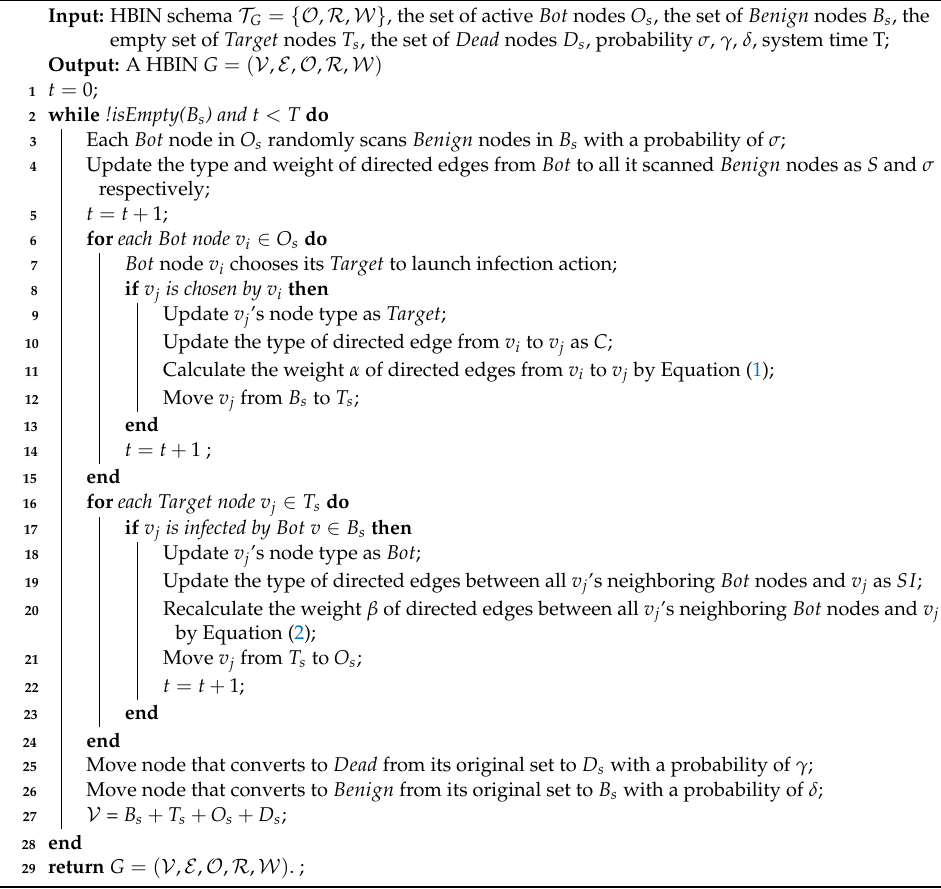
Algorithm 1: Heterogeneous Bot Infection Network Generation